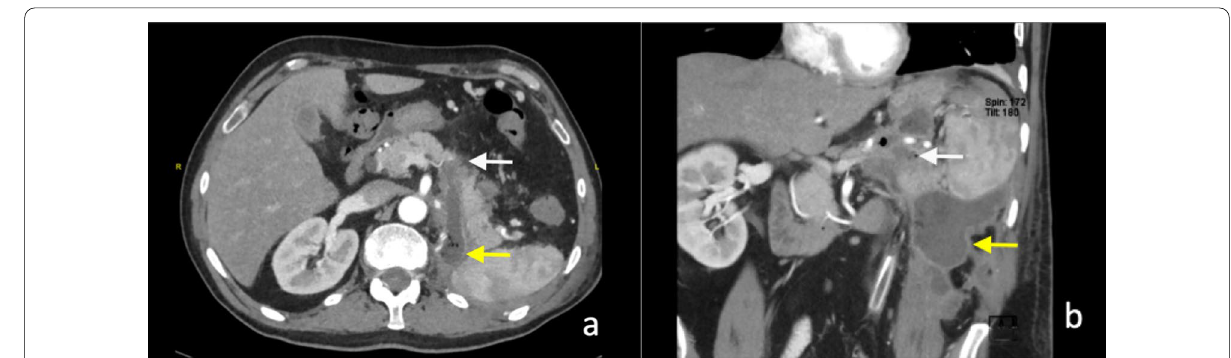
Fig. 4 a Axial and ( b ) coronal images of pancreatic injury (white arrow) with a rim-enhancing fluid- and gas-containing collection (yellow arrow) following left nephrectomy for